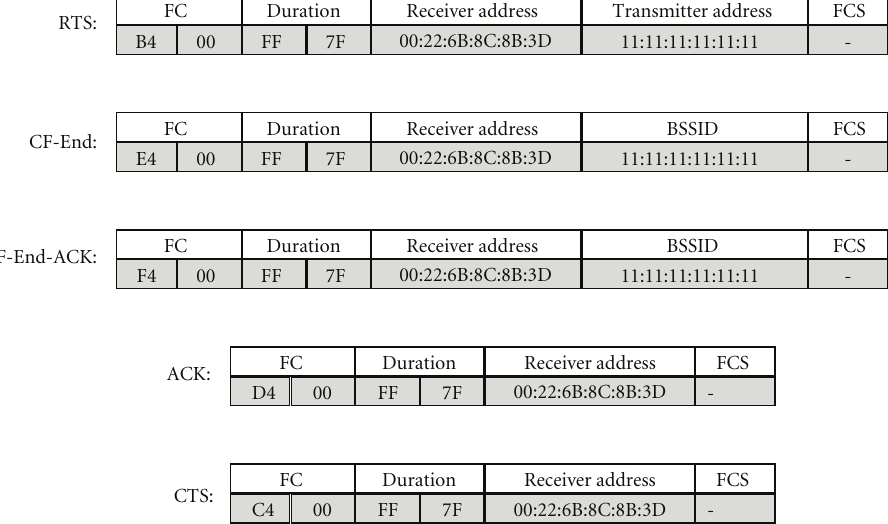
Figure 15: Bit structure of forgery control frames generated by the attacker